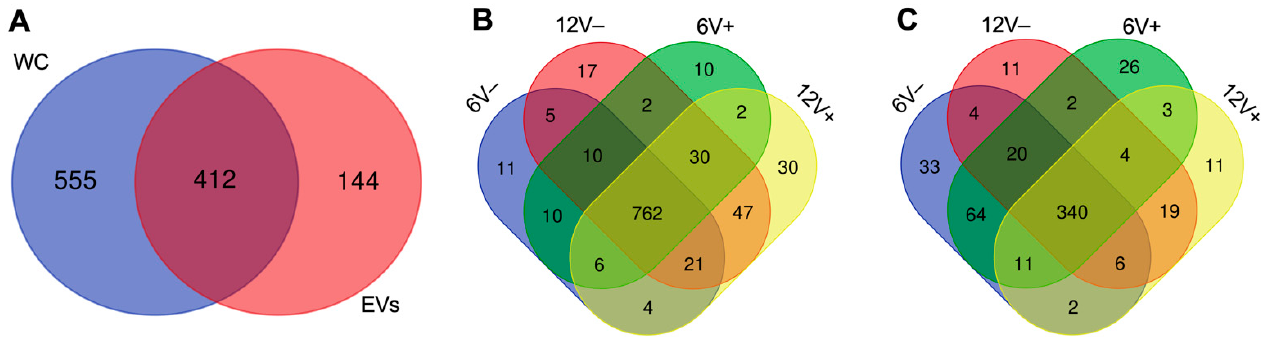
Figure 4. S. aureus HG003 WC and EV proteomes are differently modulated by growth conditions. Venn diagrams of all proteins that were identified in HG003 WC and EVs ( A ), and proteins that were identified in different growth conditions in WC ( B ) and EVs ( C ). Early- and late-stationary growth phases (6 and 12 h, respectively) in absence (V − ) or presence (V+) of vancomycin. Similar to a recent report that was published by our group on the RNA content of HG003 EVs in the same conditions, EV protein loads were higher at 6 h than at 12 h (515 vs. 433 proteins identified) [44]. EV proteins that were found at 6 h ( n = 123),